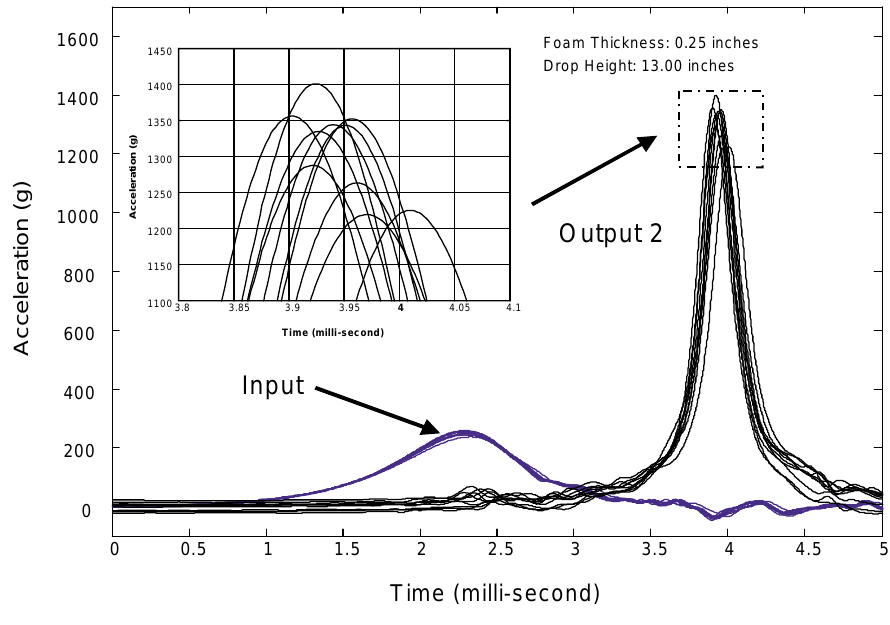
Fig. 4. Experimental Variation, Input and Output Accelerometer